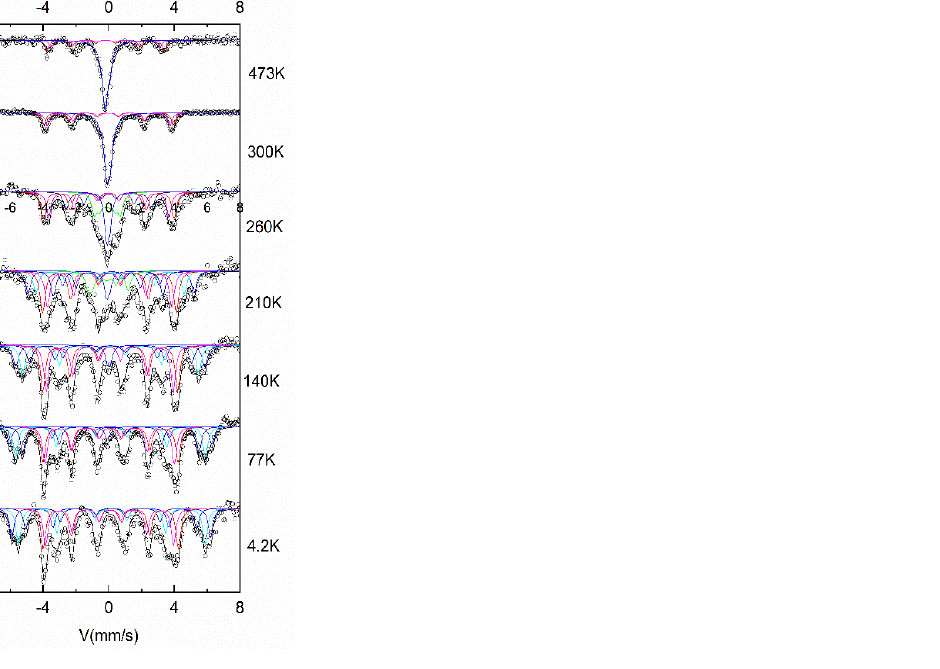
Figure 8. 57 Fe Mössbauer spectra recorded at various temperatures for the sample annealed at 700